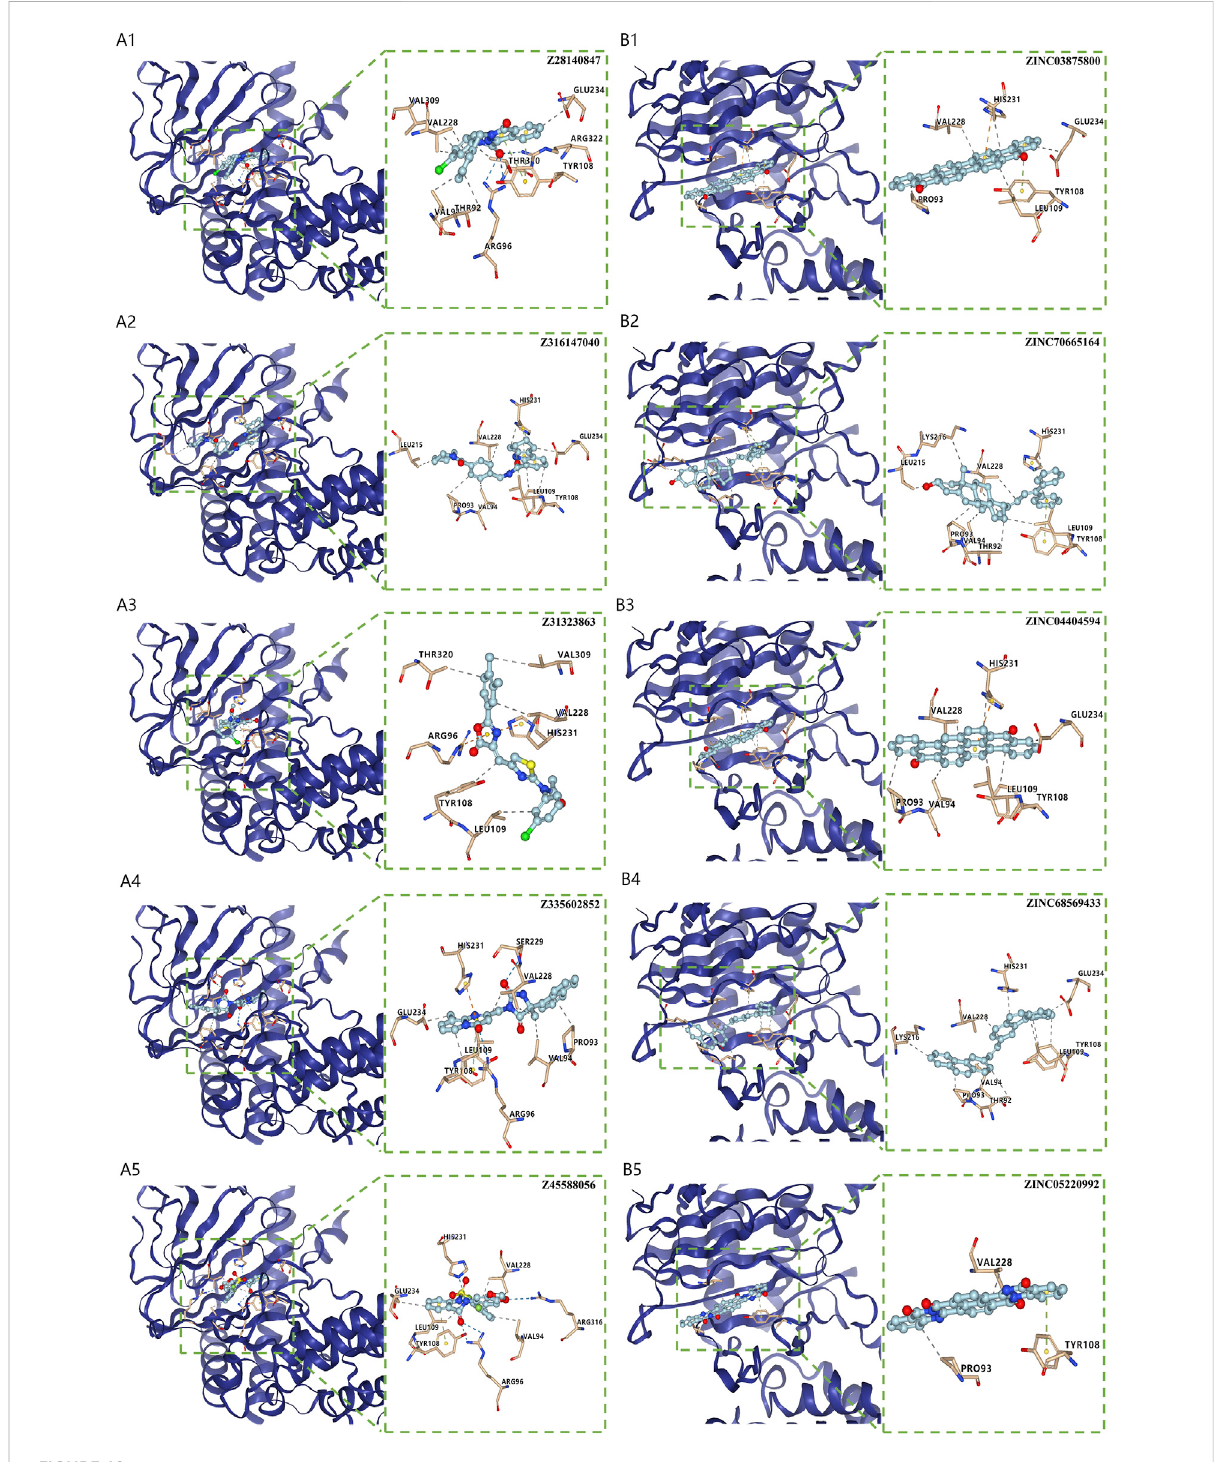
FIGURE 12 Virtual Screening for Potential Drugs Targeting FTO. (A) The top fi ve docked compounds (Z28140847, Z316147040, Z31323863, Z335602852, Z45588056)fromEnamineHTSpotentiallytargetingFTO.InteractiontypebetweeneachcompoundandFTO:Z28140847(hydrophobicinteraction, hydrogen bond, π - π stacking), Z316147040 (hydrophobic interaction, π - π stacking), Z31323863 (hydrophobic interaction, π -cation interaction), Z335602852 (hydrophobic interaction, π - π stacking), Z31323863 (hydrophobic interaction, π -cation interaction, π - π stacking), Z45588056 (hydrophobic interaction,hydrogenbond, π - π stacking). (B) Thetop fi vedocked natural products (ZINC03875800,ZINC70665164, ZINC04404594, ZINC68569433, ZINC05220992) from ZINC potentially targeting FTO. Interaction type between each product and FTO: ZINC03875800 (hydrophobic interaction, π -cation interaction, π - π stacking), ZINC70665164 (hydrophobic interaction, π - π stacking), ZINC04404594 (hydrophobic interaction, π -cation interaction), ZINC68569433 (hydrophobic interaction), ZINC05220992 (hydrophobic interaction, π - π